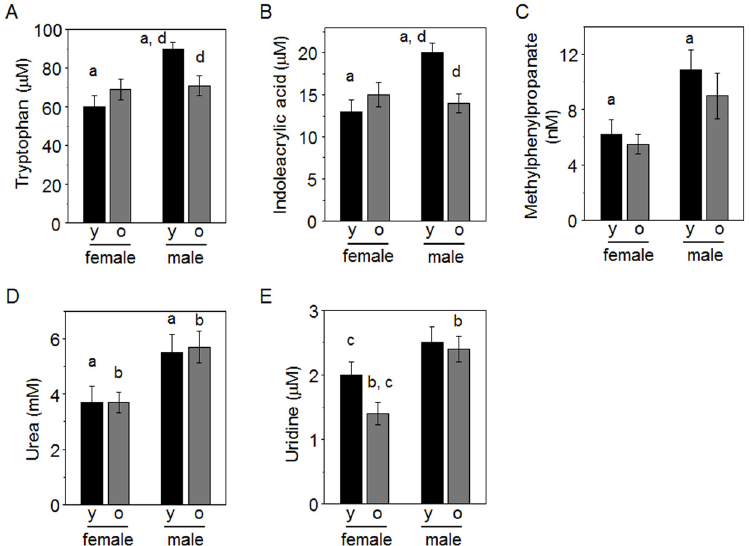
Fig 4. Metabolites higher in male than female marmosets. Female and male marmosets were grouped according to age as younger (y, 2 to 7 y) and older (o, 8 to 15 y). Following ANOVA, post-hoc tests showed differences between groups as indicated by a, female versus male in younger marmosets; b, female versus male in older marmosets; c, younger versus older females; d, younger versus older males. Group sizes were: females, 12 y, 12 o: males 13 y, 13 o.